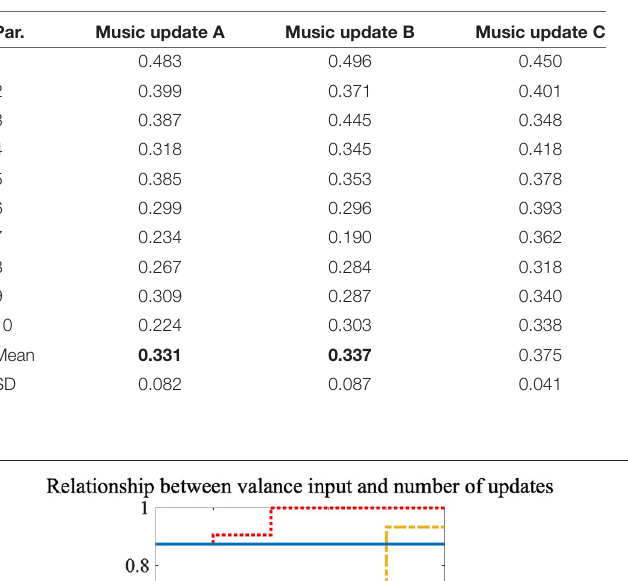
Frontiers in Digital Health |